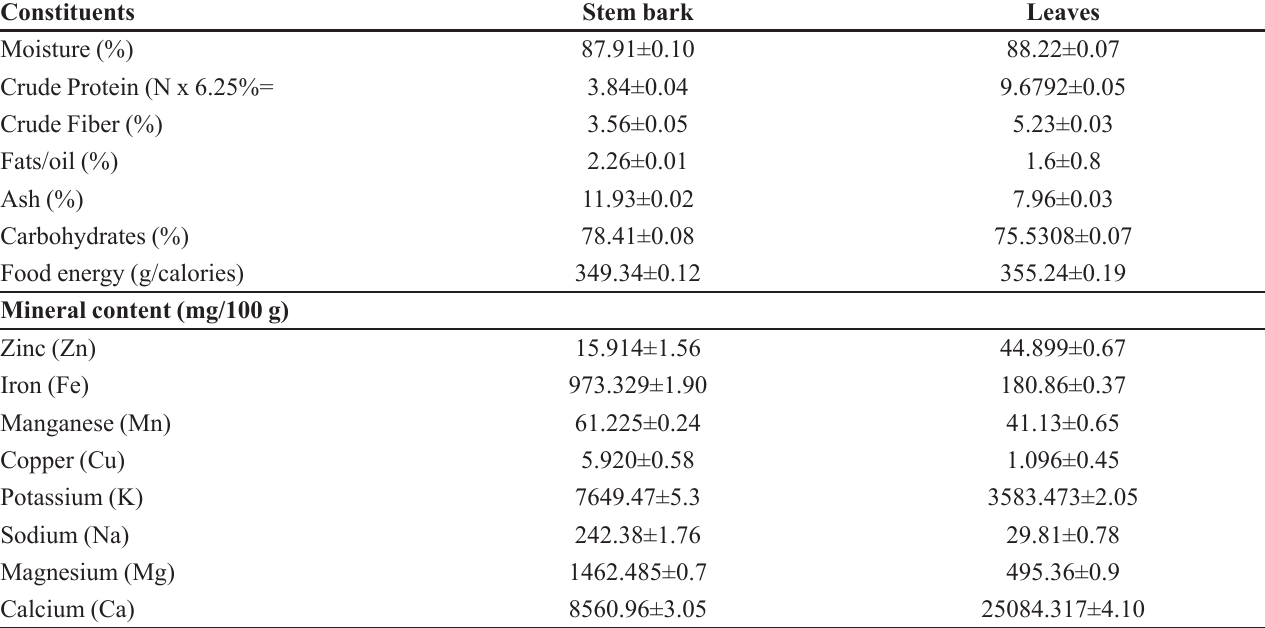
TABLE I - Proximate composition and mineral contents of leaves and stem bark Constituents Stem bark Leaves